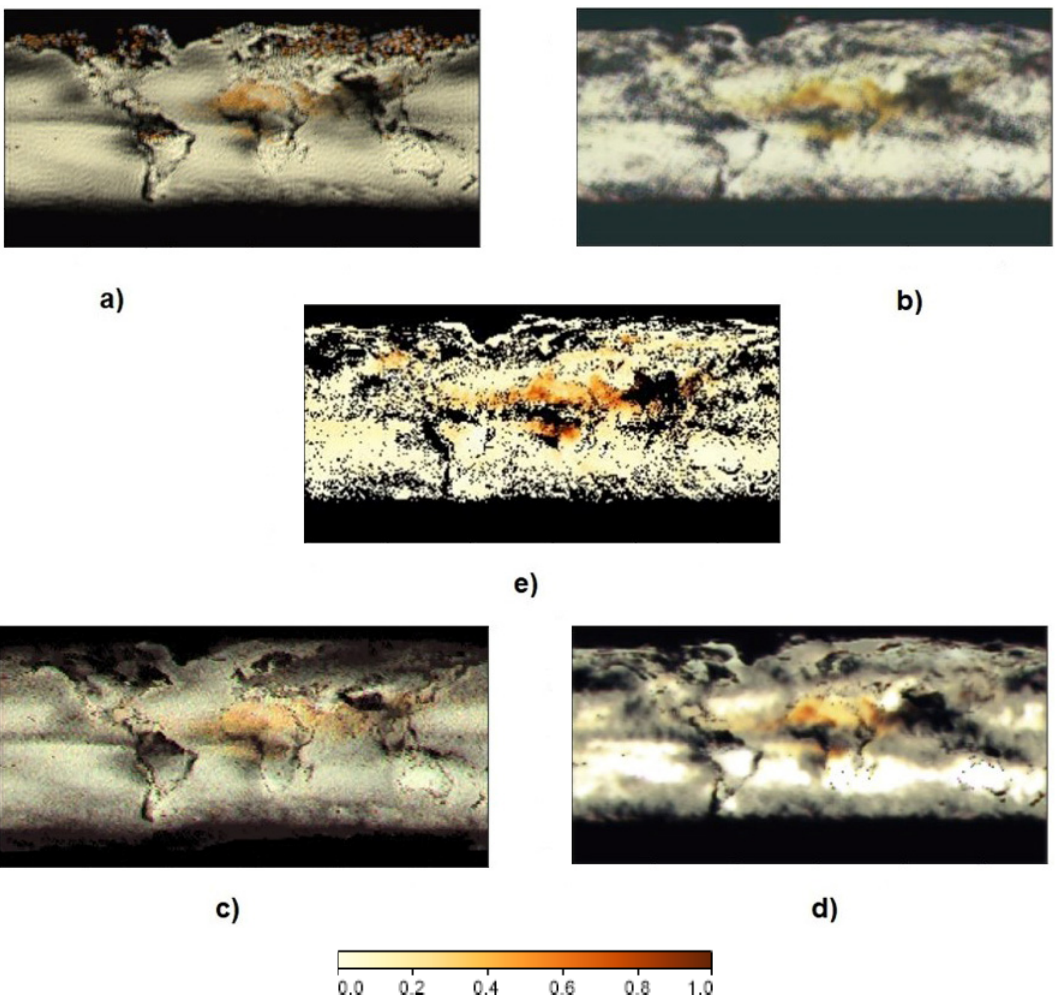
Figure 4. Prediction of the first image from the validation set using the following developed DL models: ( a ) CNN-LSTM sequence-to-sequence; ( b ) ConvLSTM sequence-to-sequence; ( c ) CNN-LSTM sequence-to-one; ( d ) ConvLSTM sequence-to-one; ( e ) original output of the first image; Color linear scale of AOT concentration values ranging from 0.0 to 1.0.